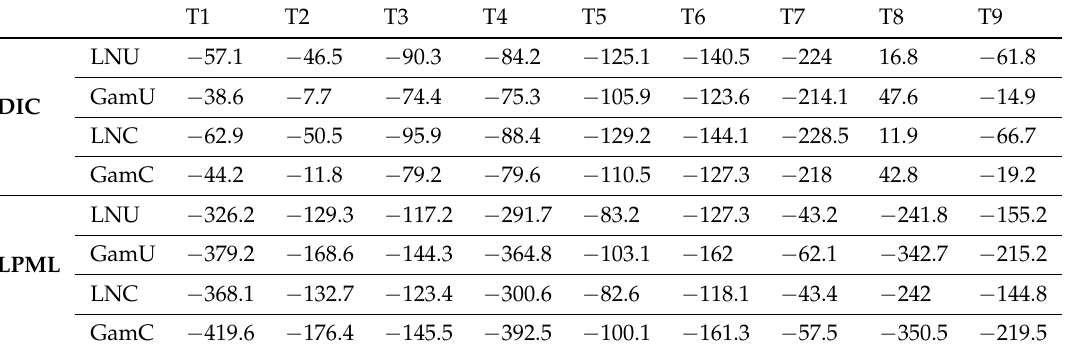
Table 4. DIC and LPML for marginal components.